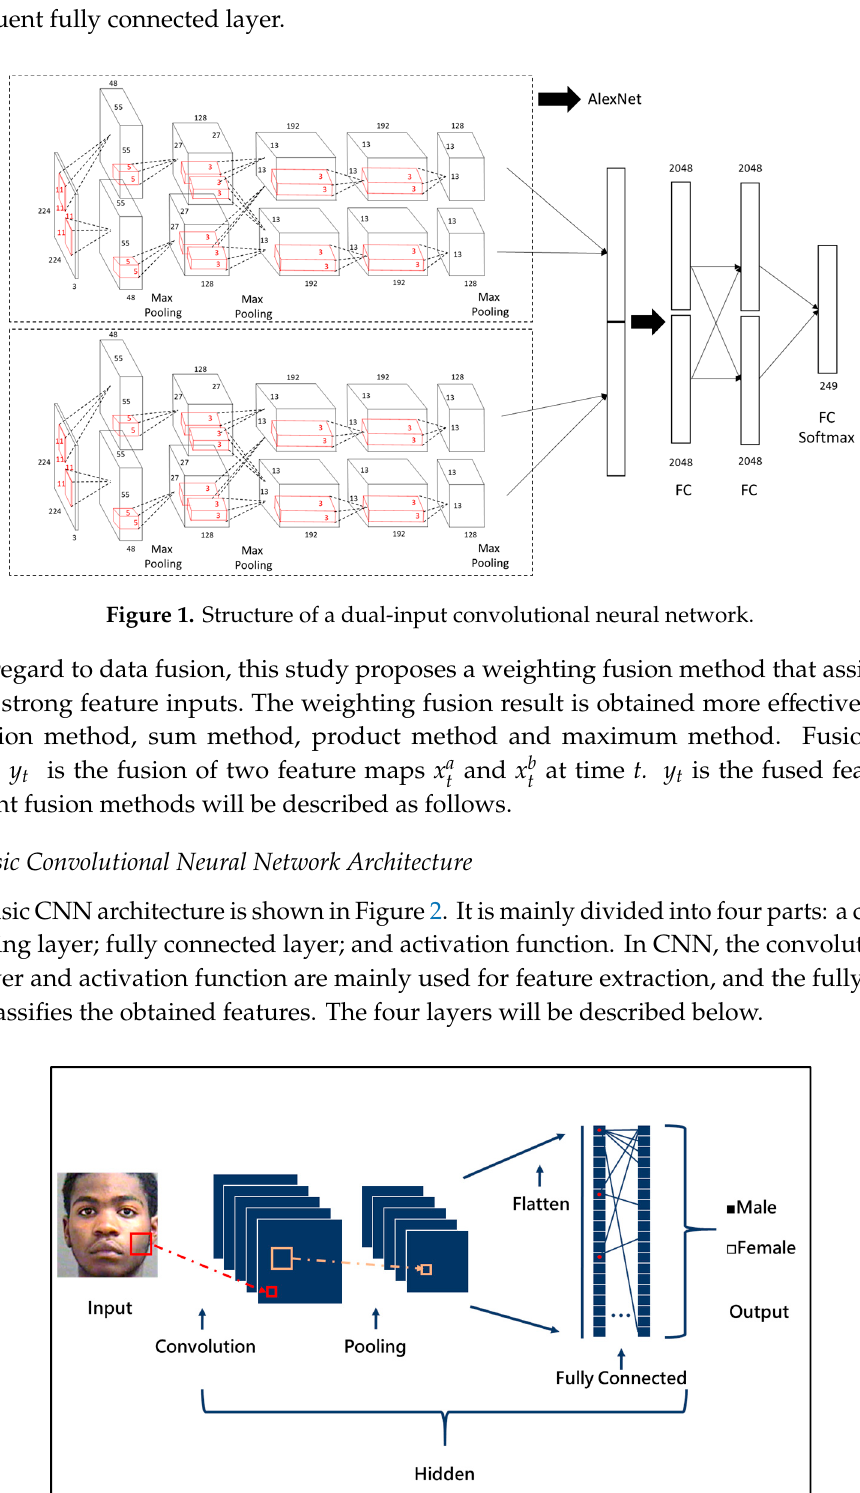
Figure 2. Structure of a basic convolutional neural network.